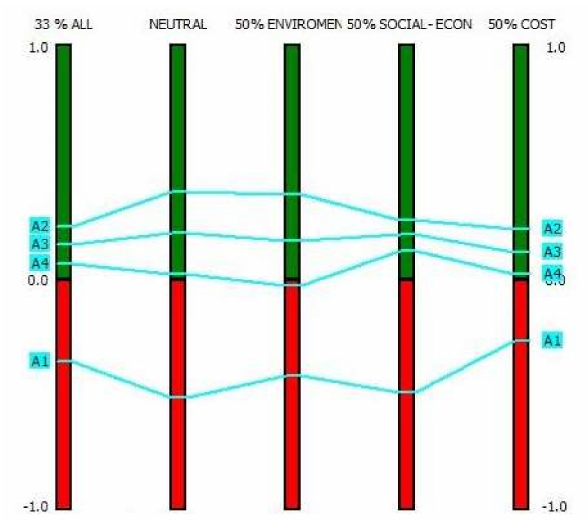
Figure 11. Result comparison of the five possible decisions for the Asvestades